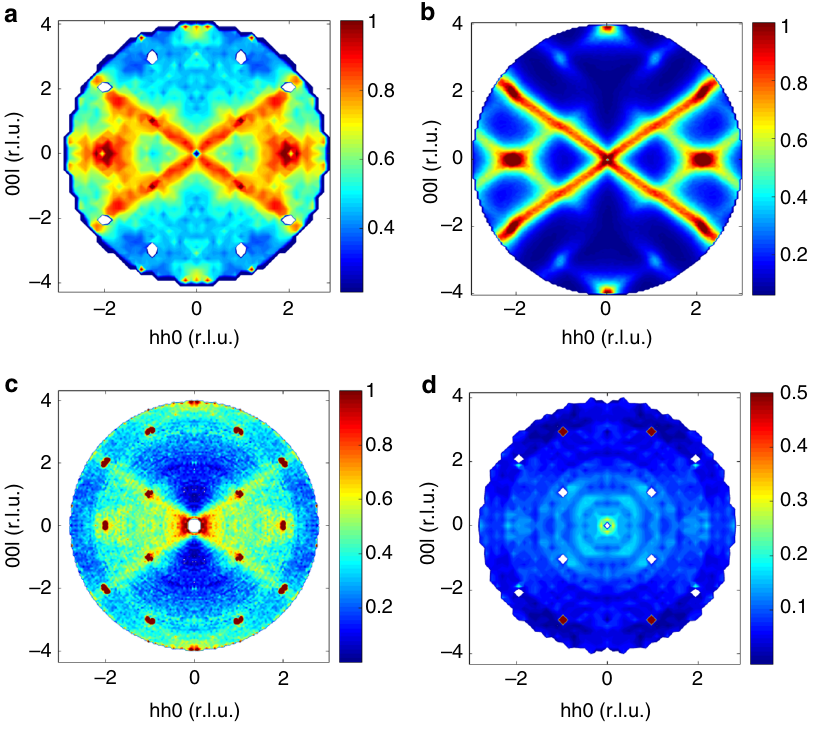
Fig. 4 Spin- fl ip scattering as a function of composition. a The spin- fl ip scattering from the as-grown sample measured at T ~ 50 mK in the ( hhl ) plane exhibits the characteristic features associated with the spin liquid phase, including the rods along [111] and broad scattering near (220) and (004). b The scattering calculated using classical Monte Carlo at T ~ 450 mK and the exchange model of ref. 30 . c The oxygen-depleted sample at T ~ 50 mK is similar to the scattering from the as-grown sample in a . d In contrast, these features are washed out for the stuffed sample at T ~ 50 mK, and instead the very broad diffuse scattering suggests mainly uncorrelated spins. The intensities are normalised to the size of crystal after background